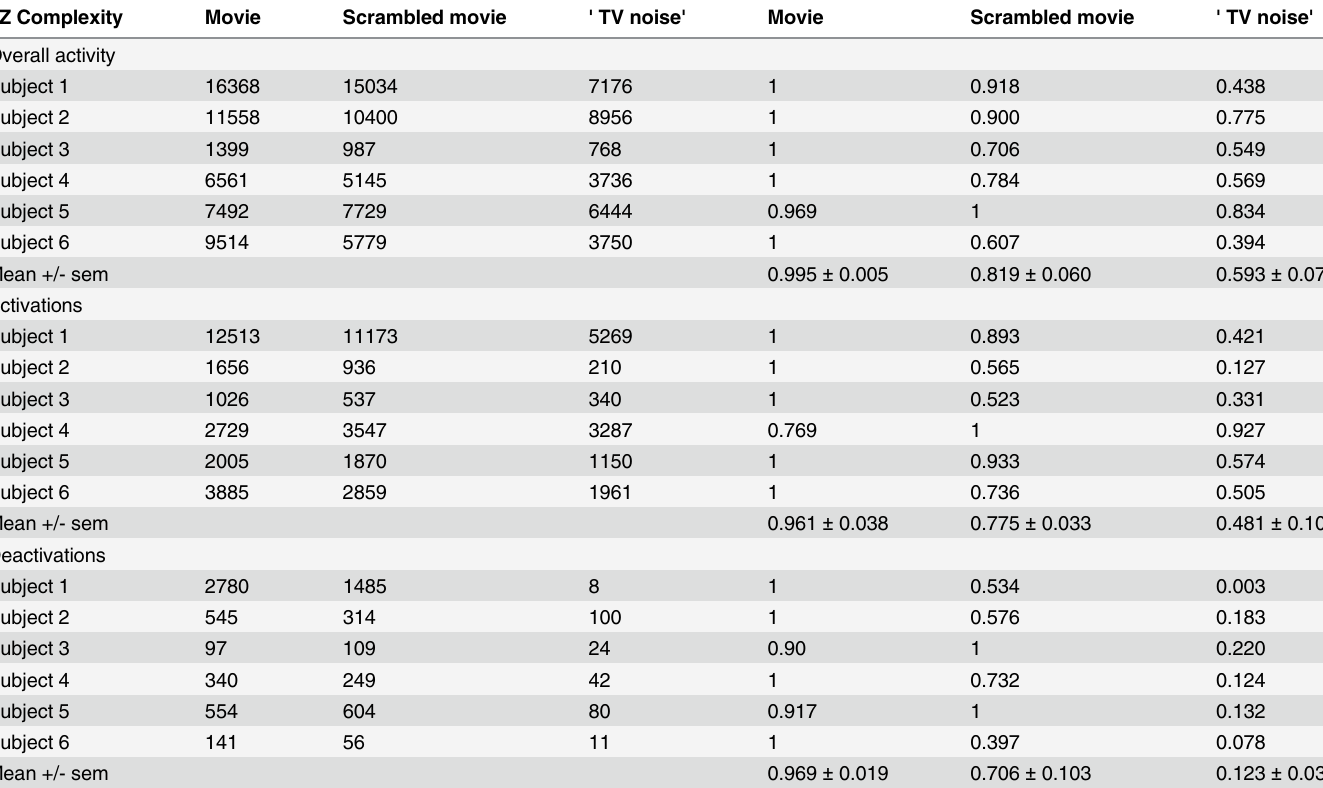
Table 2. fMRI activation/deactivation Lempel-Ziv complexity results for the differentiation analysis comparing each volume BOLD signal to a black screen baseline.